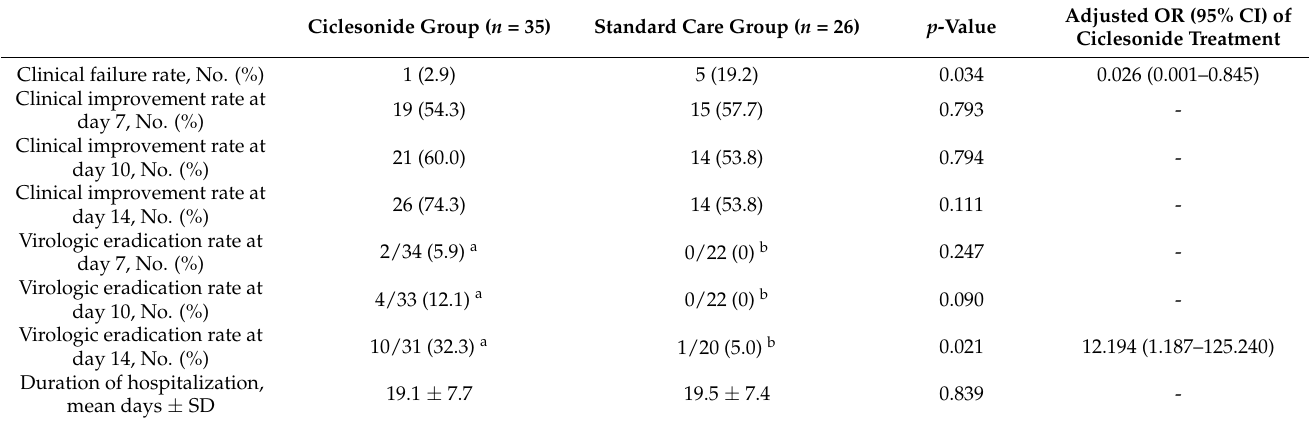
Table 2. Comparison of clinical outcomes between ciclesonide and standard care groups.